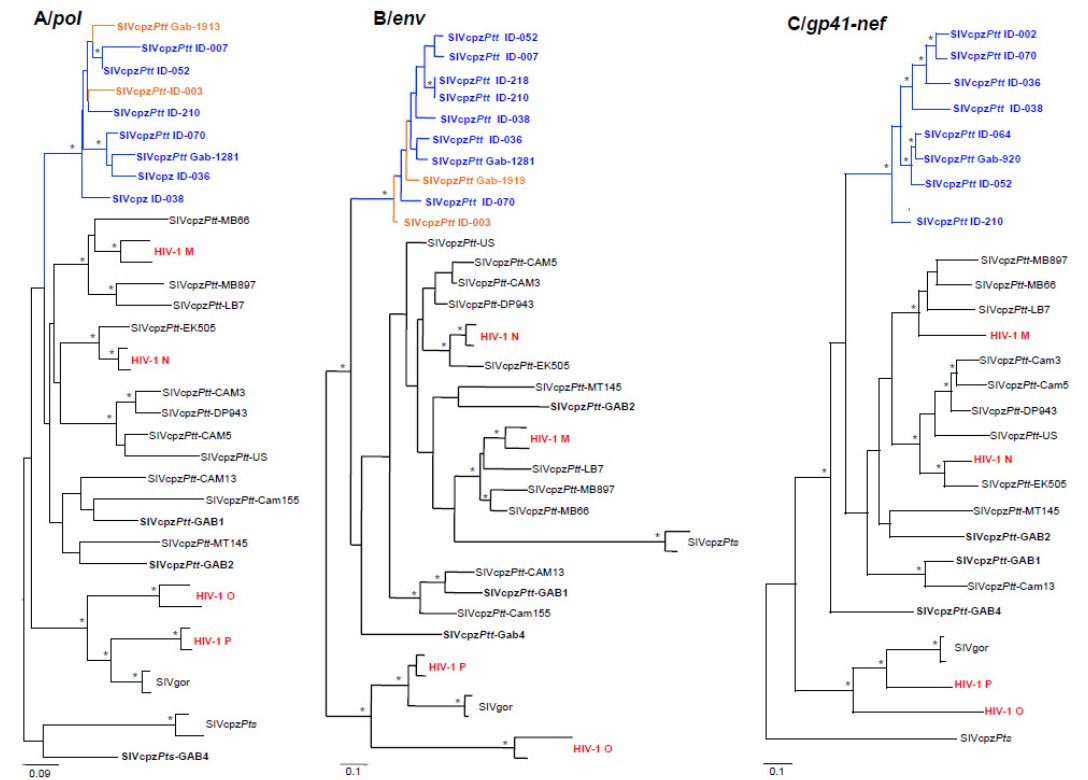
Figure 5. Phylogenetic analysis of partial pol (A), env (B) and gp41-nef (C) of the newly identified SIVcpz sequences from Gabon. New partial pol (365bp), env (325bp) and gp41-nef (916bp) SIVcpz-GAB sequences were compared to previously identified SIVcpz Ptt and SIVcpz Pts as well as HIV-1 goups M, N, O and P. Phylogenies were inferred using Maximum Likelihood methods implemented in PhyML under the GTR+ Γ 4 +I model of evolution. Asterisks at nodes represent bootstrap values ě 70% (1000 replicates). Scale bars indicate the number of base substitutions per site. New SIVcpz strains are